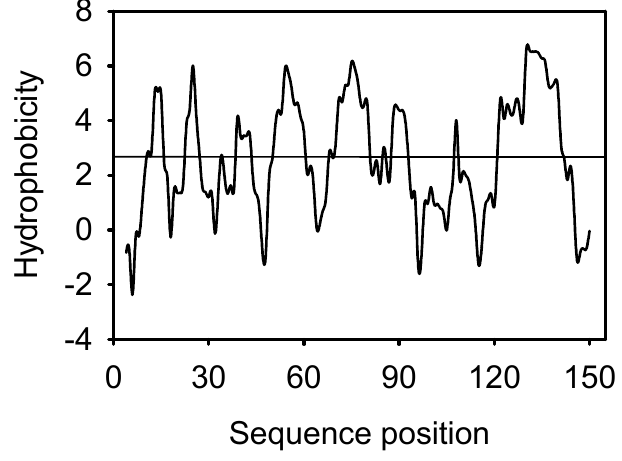
Figure 11. Predicted hydrophobic regions of cSOD1 using the method of Parker, et al . [44]. The hydrophobic residues forming the dimer interface are directed under the threshold value and represented by the residues V6, V8, T18, FGDNT (50–54), IGR (113–115) and VIGIAQ (148–153). The electrostatic interacting residues are directed above the threshold line and represented as E132, E133, K136 and